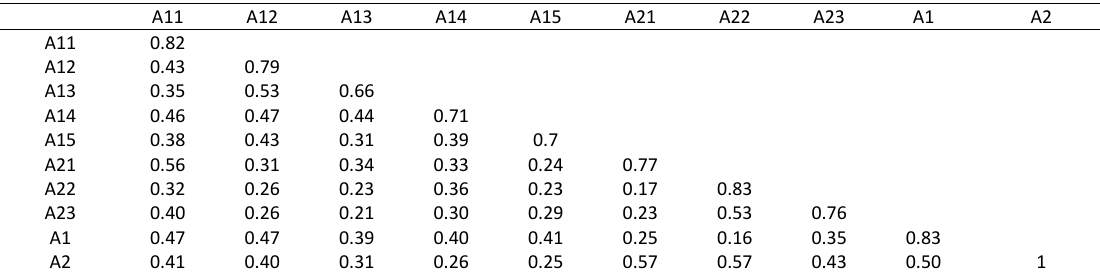
Table 6: Divergent validity